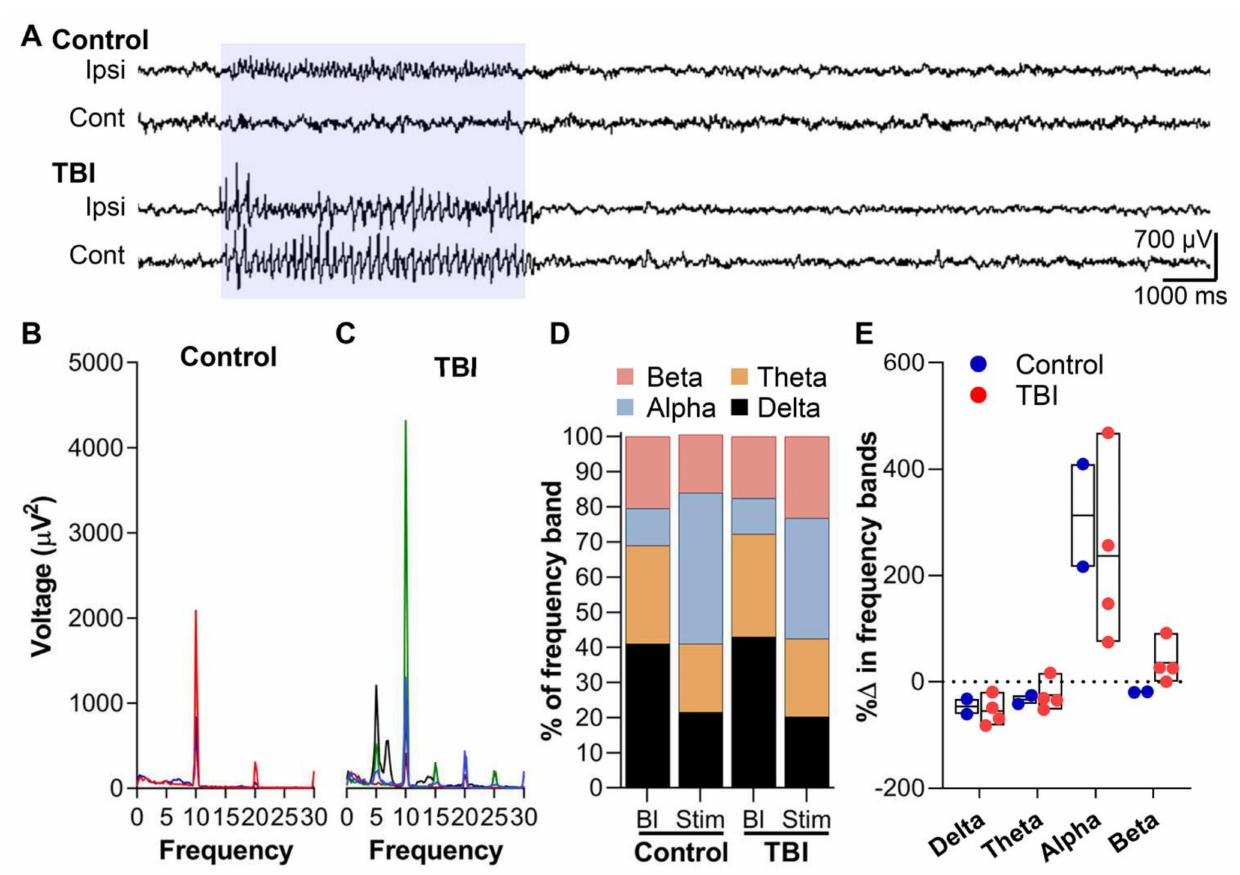
Figure 7. Optogenetic activation of the channel rhodopsin 2 (ChR2)-transduced thalamo-cortical network. ( A ) EEG record- ings demonstrating spiking unilaterally in the control and bilaterally in the TBI rat during a 5-s 10 Hz optogenetic stimulation with blue light (470 nm). Note the high-voltage activity in the TBI rat compared with controls. ( B ) Spectral analysis of EEG activity during optical stimulation in control rats showed peak activity at 10 Hz stimulation frequency. Also, note the other peaks at 20 and 30 Hz. ( C ) TBI rats with spiking activity in the EEG also displayed a peak activity at 10 Hz in the EEG spectral analysis during the optical stimulation. Unlike the controls, however, they showed repeated peaks at every 5-Hz interval. ( D ) The percentage of the voltage of the different frequency bands at baseline and during the optical stimulations in controls and TBI rats. ( E ) Suspended box plot of percentage change in voltage of the frequency bands normalized to baseline values. Control and TBI rats showed an increased alpha frequency (corresponding to the stimulation frequency) whereas only TBI rats showed a tendency towards a high beta activity, indicative of possible network